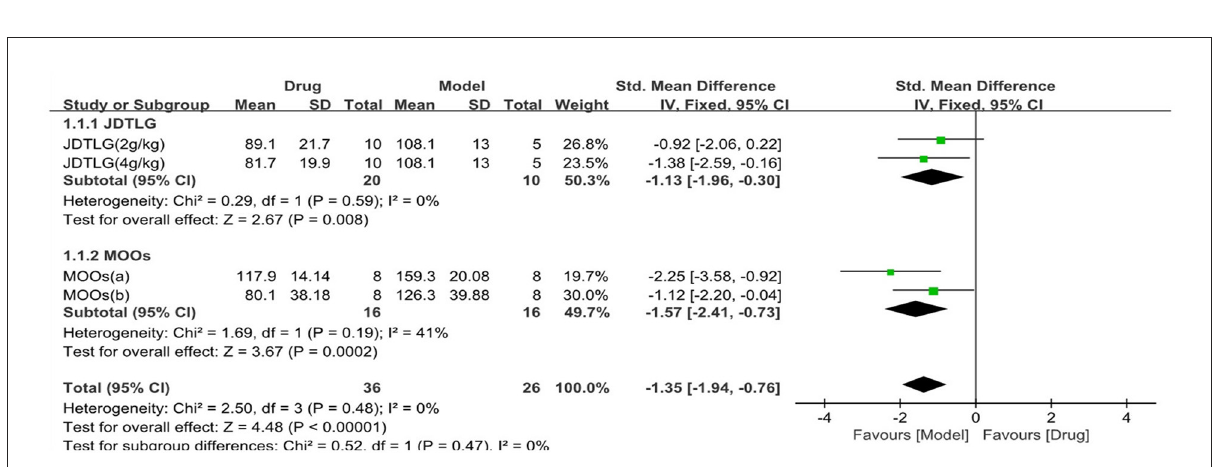
FIGURE5 Efficacy of CHM on tail suspension test. Forest plots of the effect size calculated using SMDs. The horizontal error bars represent the 95% confidence interval of individual